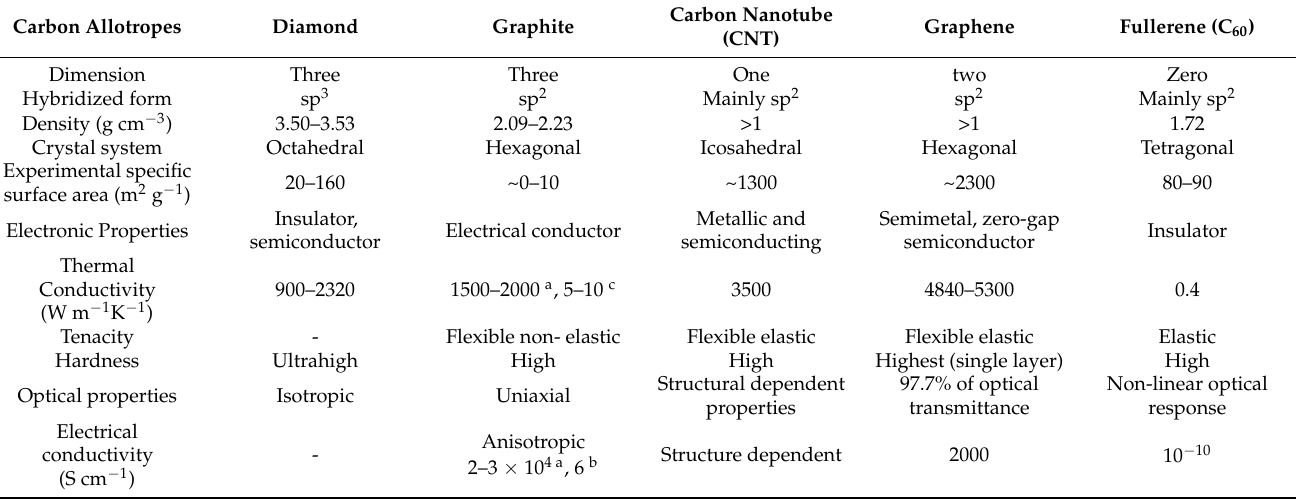
Table 1. Physical and electronic properties of different allotropes of carbon. Adapted and reproduced from Ref.